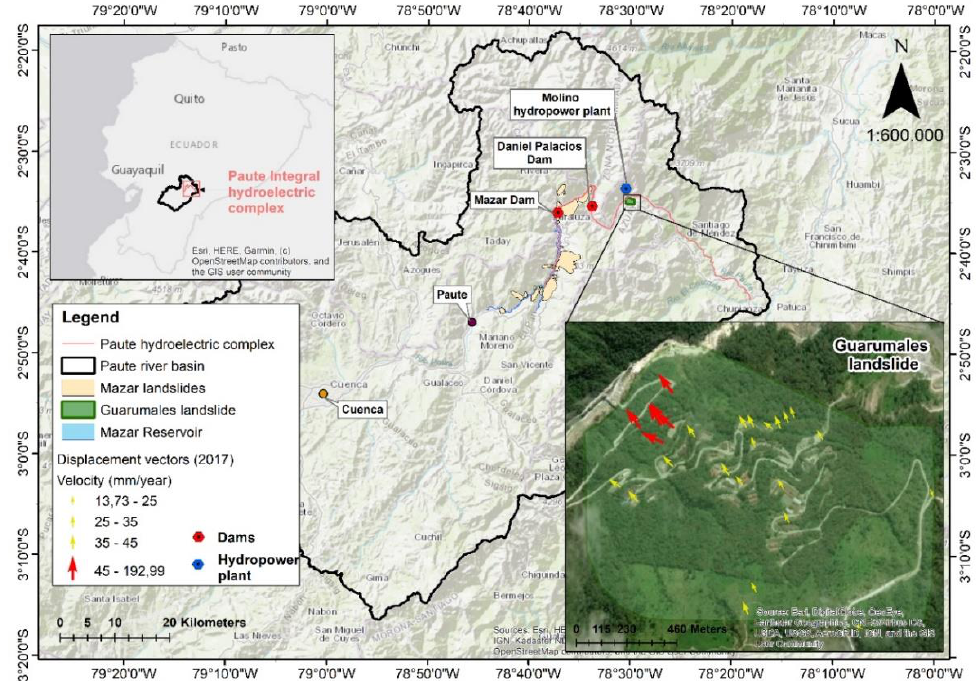
Figure 1. Location of the 21 landslides around Mazar and Molino hydropower facilities, including the Guarumales landslide.